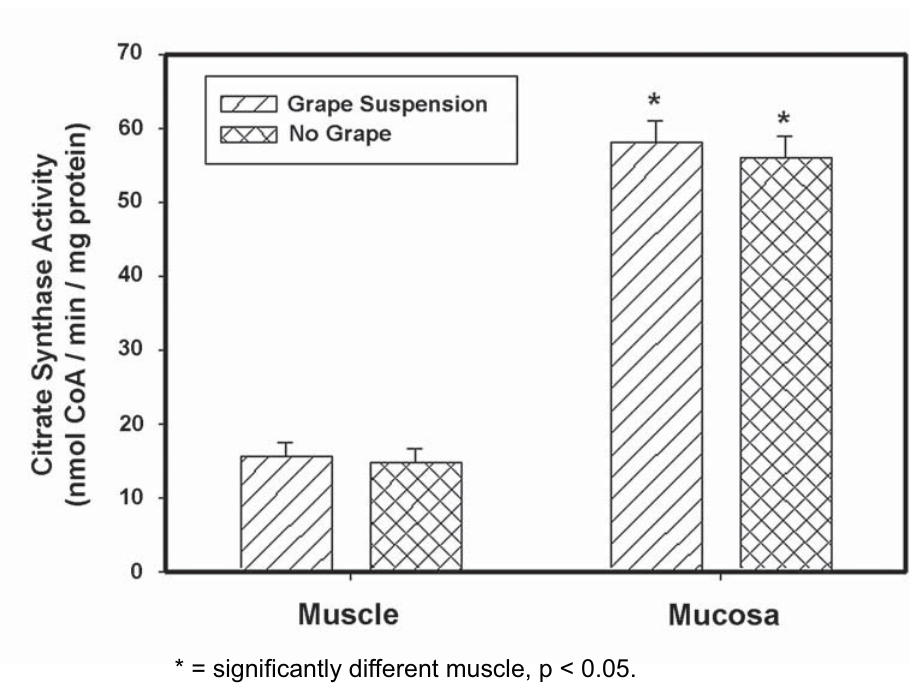
Figure 2 – Comparison of the citrate synthase activities of rabbit bladder muscle and mucosa in the presence and absence of the grape suspension. Each bar is the mean ± SEM of 6 individual